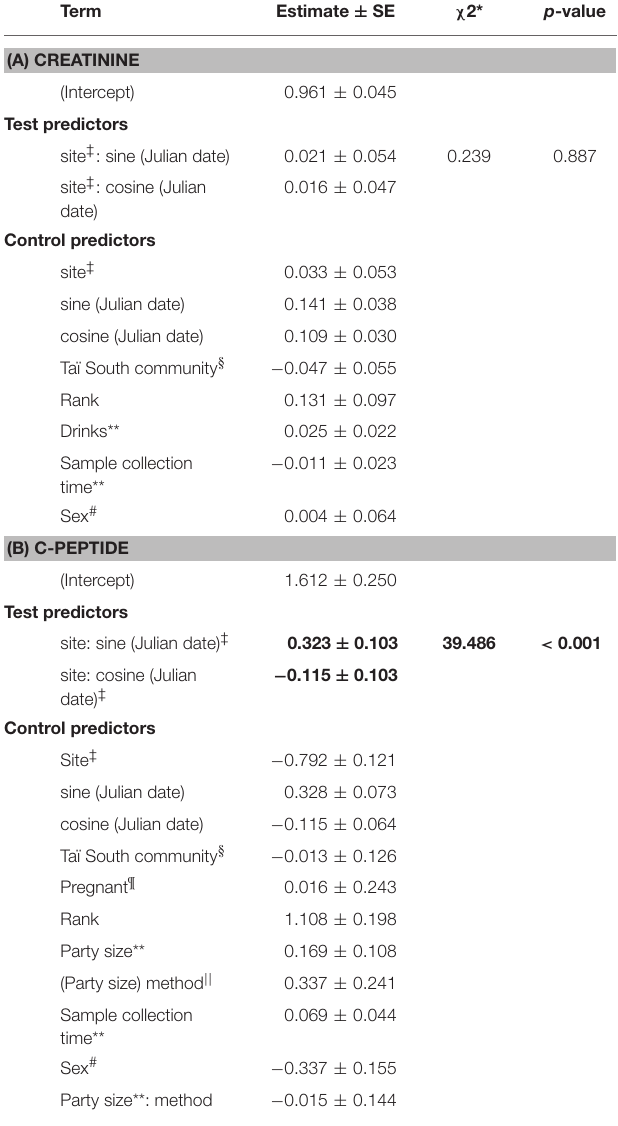
TABLE 1 | Results of models comparing seasonal variation in (A) creatinine, (B) c-peptide, and (C) cortisol levels. Term Estimate ±